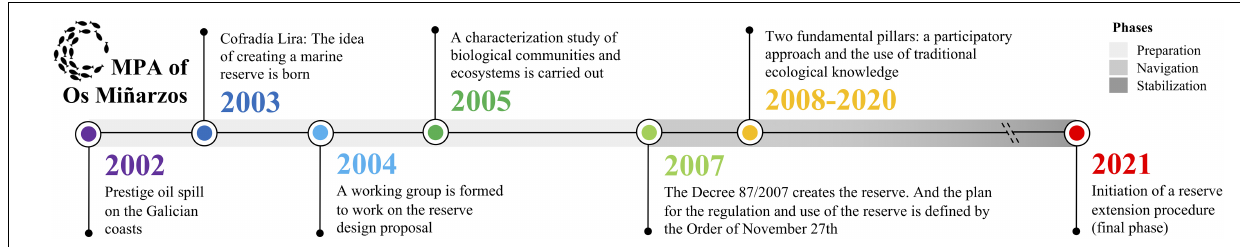
FIGURE 9 | Main landmarks of the Marine Reserve of Fishing Interest of Os Miñarzos (Lira, Galicia) from 2002 to 2021.